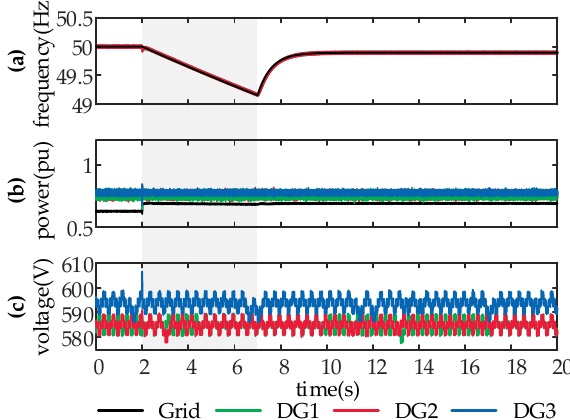
Figure 8. Responses to sudden load variation when conventional PV systems are applied as DG1–DG3: ( a ) Frequency response; ( b ) output active power; ( c ) dc link voltage of the inverter.